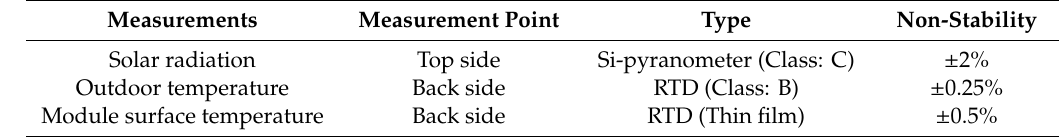
Table 4. Specification of sensors.